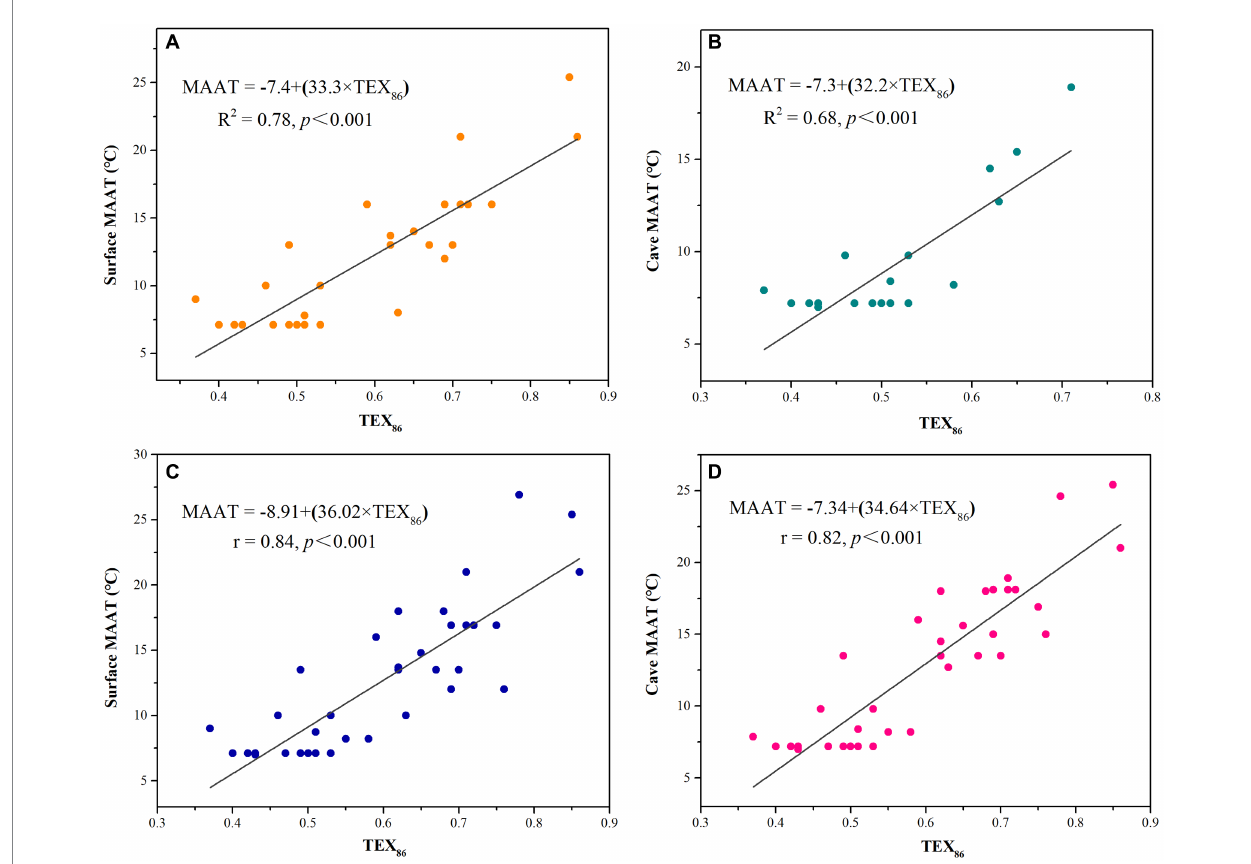
FIGURE 4 Relationships between TEX 86 , surface MAAT, and cave MAAT (data A and B from Blyth and Schouten, 2013; data C and D from Yang et al., 2011; Blyth and Schouten, 2013; Baker et al.,